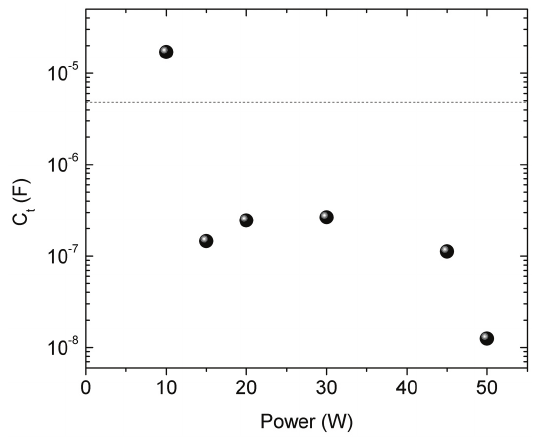
Figure 17. Total capacitance as a function of P for films deposited from HMDSO/O with plasma excitation powers ranging from 10 2 to 50 W. Dashed line corresponds to the uncoated polished